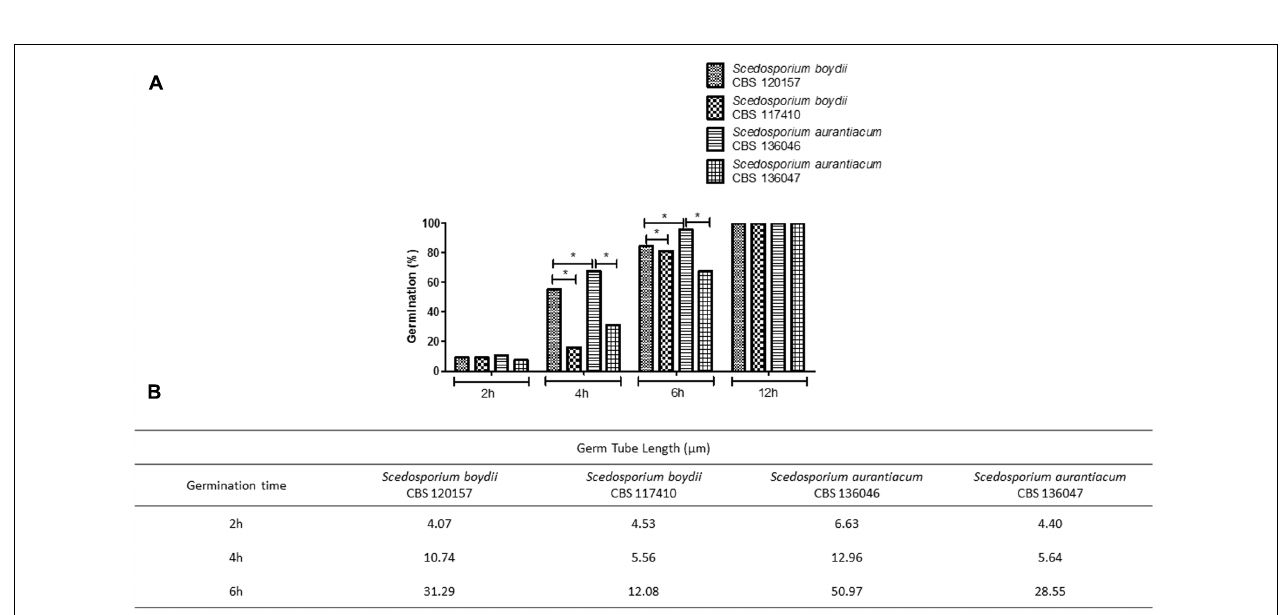
FIGURE 2 | Germ tube formation in clinical and environmental strains of Scedosporium boydii and S. aurantiacum . (A) The germination process was monitored over time and quantified by counting the percentage of germinated cells at selected time points (2, 4, 6, and 12 h). (B) Germ tube length was monitored during the germination process at selected time points (2, 4, or 6 h). Statistical differences ( P < 0.05) are represented by asterisks.